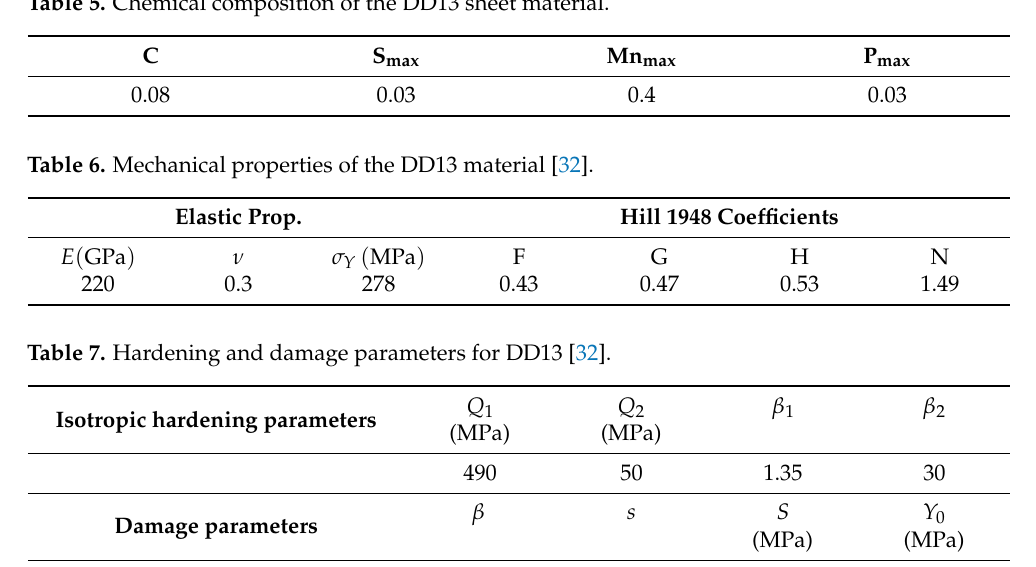
Table 5. Chemical composition of the DD13 sheet material.